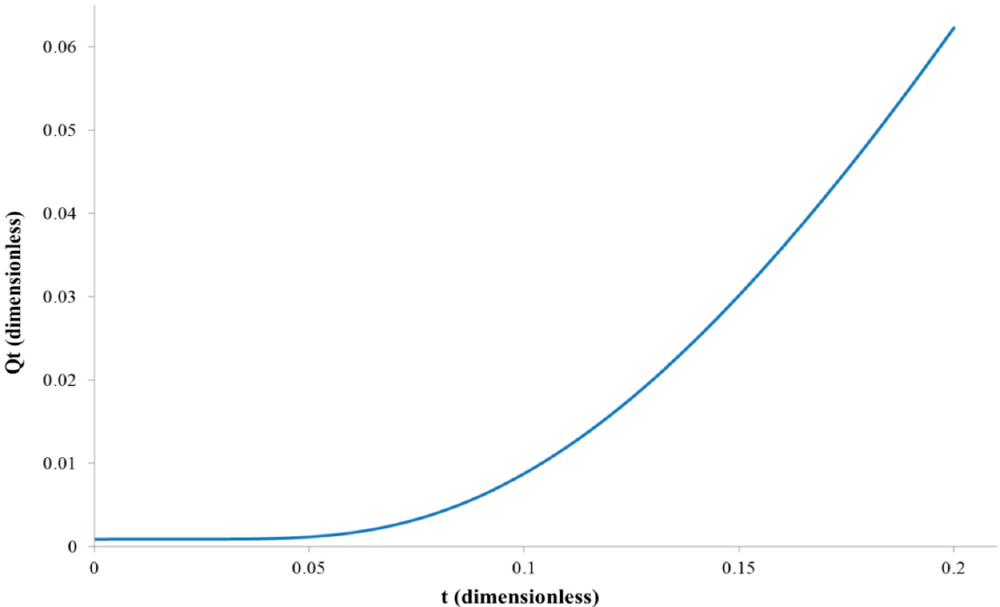
Figure 1. The relation between the total amount of diffusing substance and the time in the most common experimental permeation arrangement, i.e., C 0 = C 2 = 0.